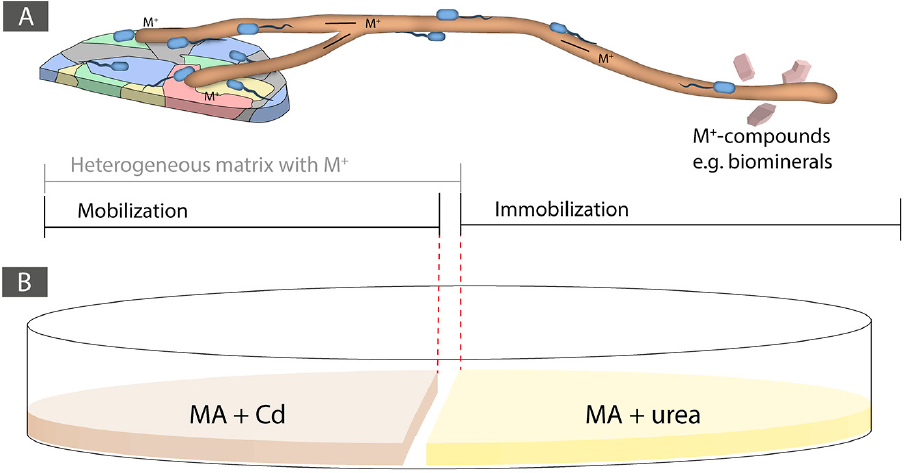
Figure 1. ( A ) Conceptual design of the approach using bacterial-fungal interactions and fungal highways for the biorecovery of metals in a heterogeneous and unsaturated matrix. On the left-side, a mobilization area is shown consisting of a metal-containing heterogeneous area such as an e-waste and on the right-side is shown an immobilization area where biologically induced mineralization (i.e., biomineralization) can take place for the biorecovery of a metal fraction. ( B ) Experimental set-up of the Cd mobilization and immobilization Petri dish experiment.